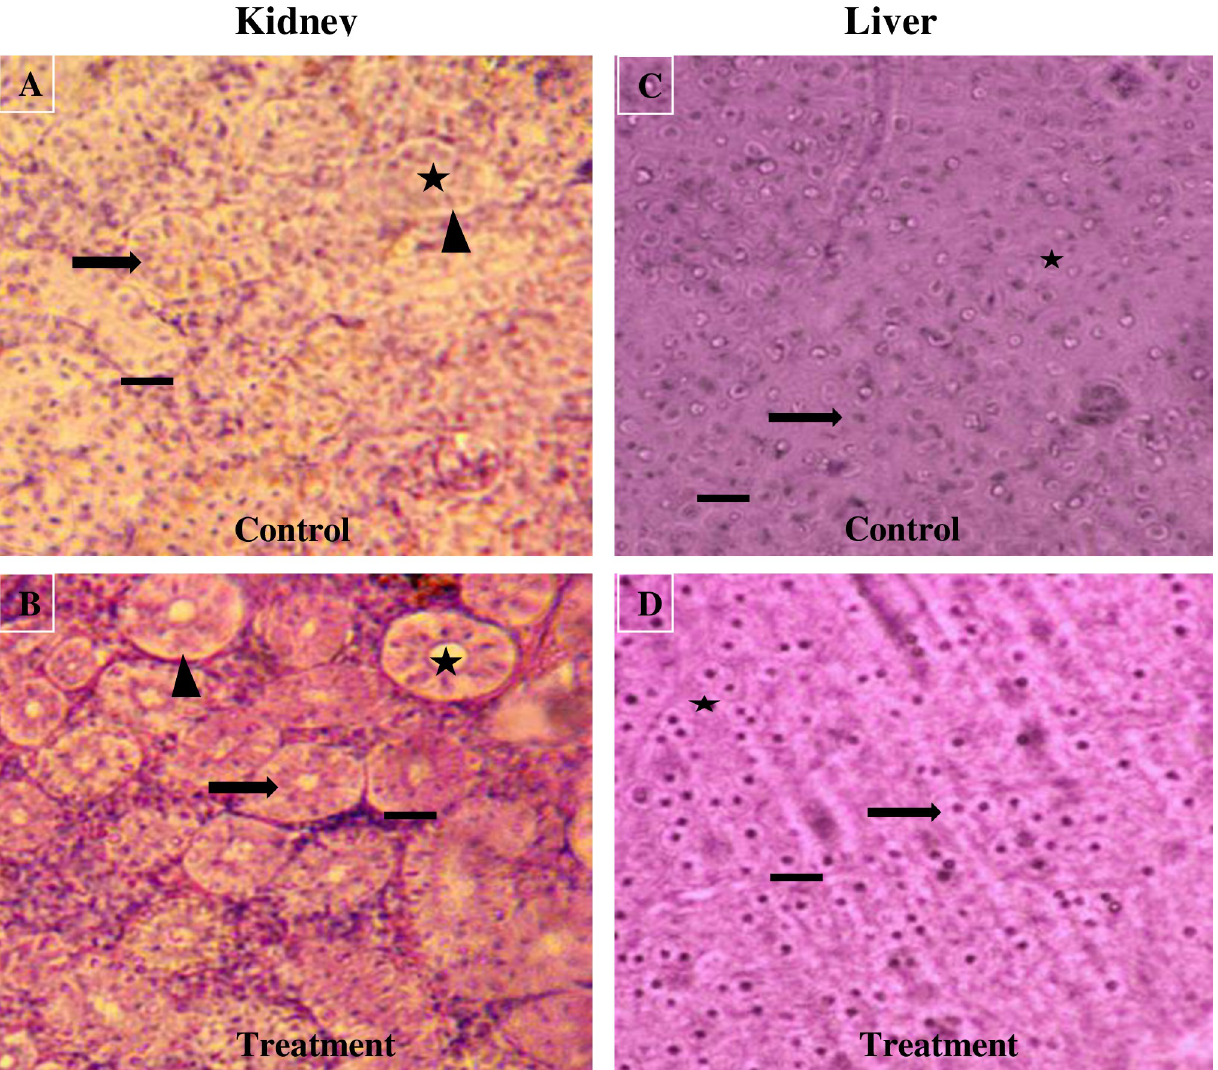
Fig 6. Histological analysis of the effects of dietary chitosan on the kidneys (A and B) and liver (C and D) of B . gonionotus . Fish were fed a (A and C) control diet (chitosan at 0 kg -1 feed) or dietary chitosan at 1 g kg -1 (B and D). (A) shows an unclear renal corpuscle (arrow), glomerulus (asterisk), Bowman’s space (arrowhead) and proximal tubules. (B) represents a more well-defined renal corpuscle, glomerulus, Bowman’s space and proximal tubules than A. (C) shows unclear hepatocytes (arrow) with irregularly shaped nuclei (asterisk). (D) shows hepatocytes with regularly shaped nuclei. Six fish were considered for each treatment. Image 40 × ; scale bar = 50 μ m; H & E 200; n = 9.